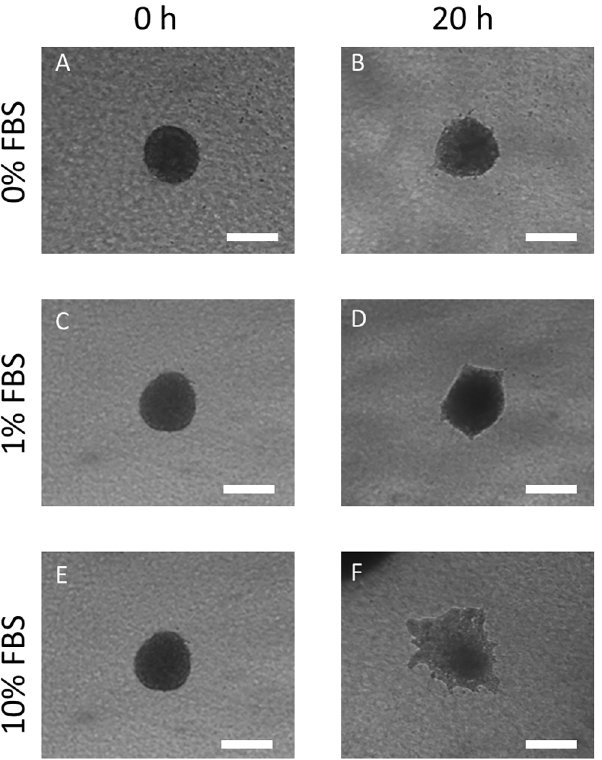
Fig 4. FBS influence on OSC – 19 spheroid invasion. OSC – 19 spheroids were embedded in collagen hydrogel in a six well plate and growth media supplemented with 0% FBS (A and B), 1% FBS (C and D) and 10% FBS (E and F), was applied over them. Photos were taken at embedding time (0 hours) and after 20 hours. Scale bar is 200 μ